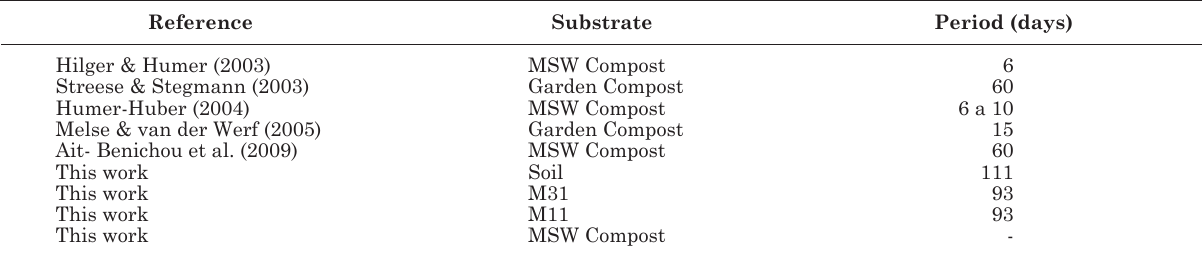
table 5. some adaptation phases reported in the literature compared with the periods observed for the four biofilters used in this work